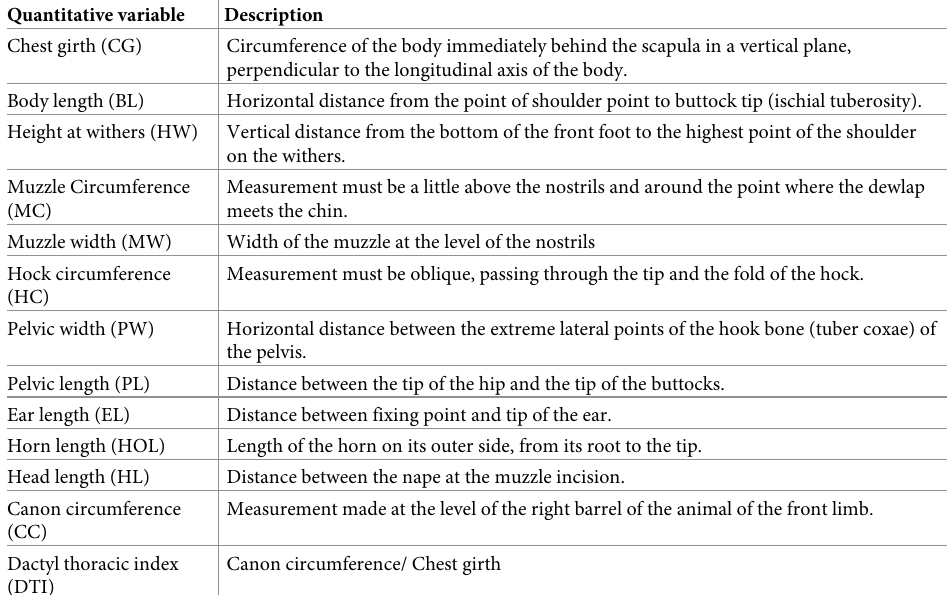
Table 2. Morphological traits measured on 130 indigenous cattle in Guelma region